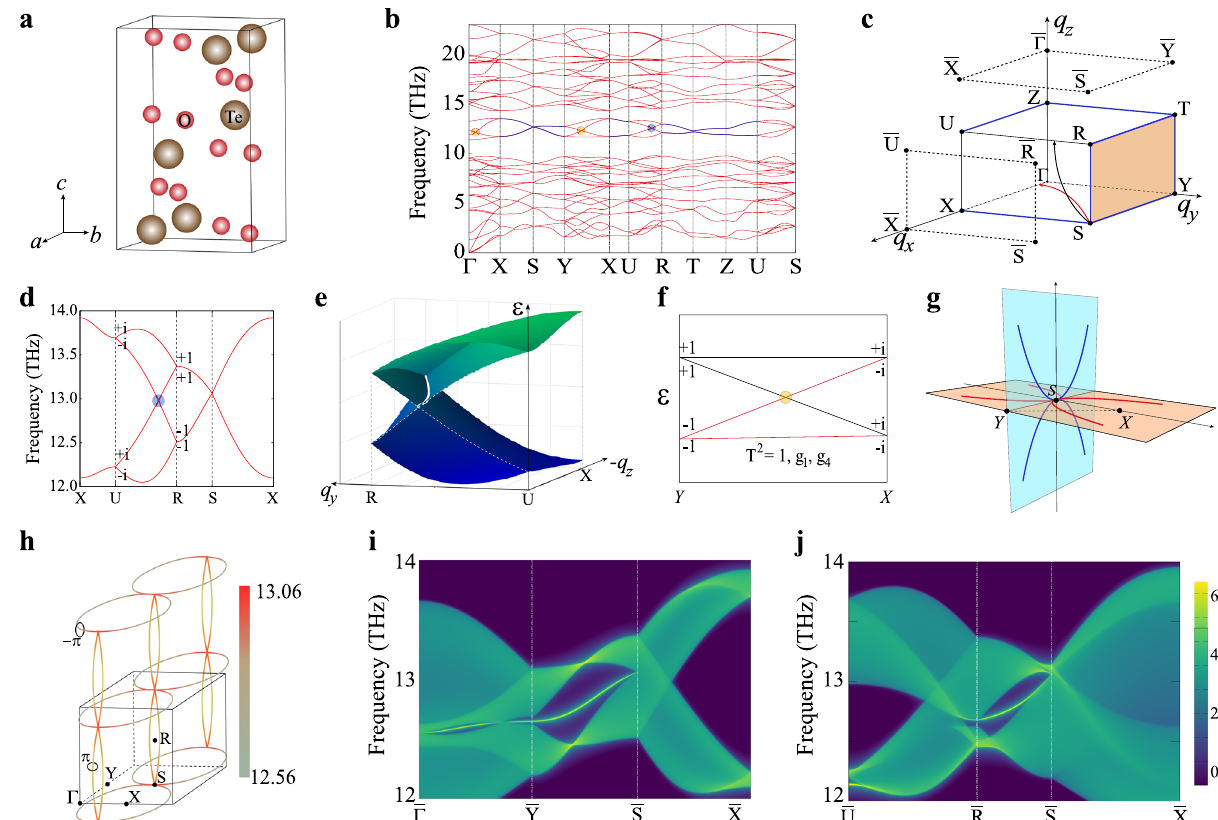
Fig. 5 Hourglass nodal-net TPs of TeO 3 . a The unit cell of TeO 3 (space group Pnna 52). b The phonon dispersion of TeO 3 . c The bulk BZ and the (001) and (100) surface BZs. Both the red and black arrows denote the hourglass nodal-line TPs, whereas the blue lines along the BZ boundary represent the twofold degenerate nodal-line TPs. All points on the q y = π plane are twofold degenerate nodal points (called twofold degenerate nodal surface), as shown in the yellow plane. d The phonon spectrum along X – U – R – S – X at the q yz plane. The eigenvalues of { M x ∣ b /2 + c /2} are given at both U and R points. e The 3D phonon dispersions at the q yz plane. The solid white line represents the hourglass nodal line on which any point represents a hourglass nodal point. f The phononic hourglass nodal dispersions protected by g 1 and g 4 . The eigenvalues of { M z ∣ a /2} are given at both Y and X points in the BZ. g Hourglass nodal chains (HNCs) at the q xy plane (red solid lines) and at the q yz plane (blue solid lines). Both these HNCs connect to each other only at the S point to form an hourglass nodal net (HNN) in the extended BZ. h The shape of the HNN in the three-dimensional view. Two black circles are used to calculate the Berry phase of the HNCs and the color represents the energy dispersion of the HNN in THz. i , j The phononic surface states along the high-symmetry lines for the (001) and (100) surfaces,